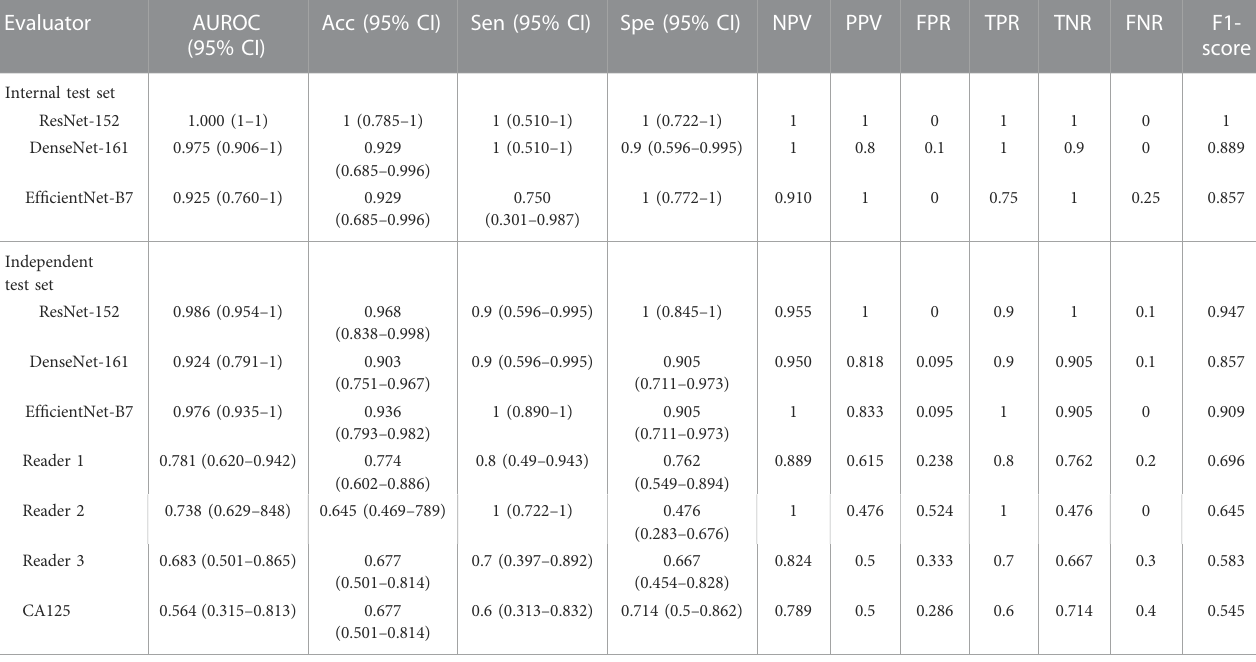
TABLE 2 Performance of ResNet-152, DenseNet-161, Ef fi cientNet-B7, CA125, and readers.